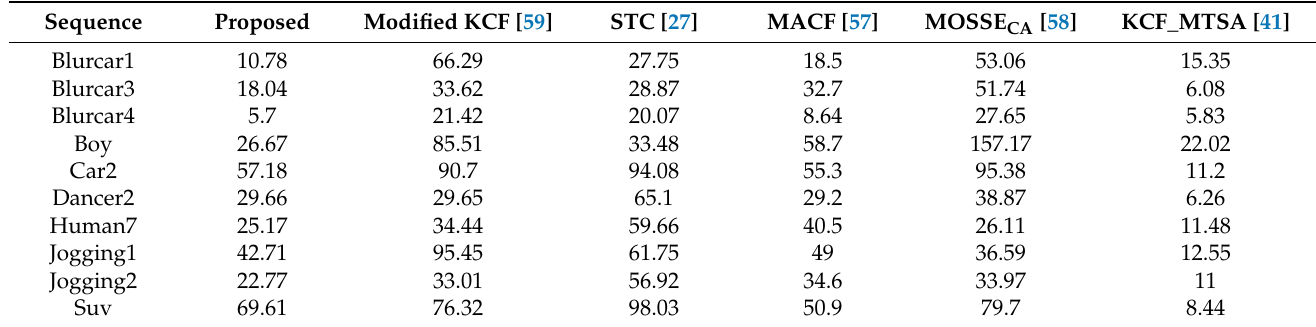
Table 4. Computation time of the proposed tracker’s learning rate module.